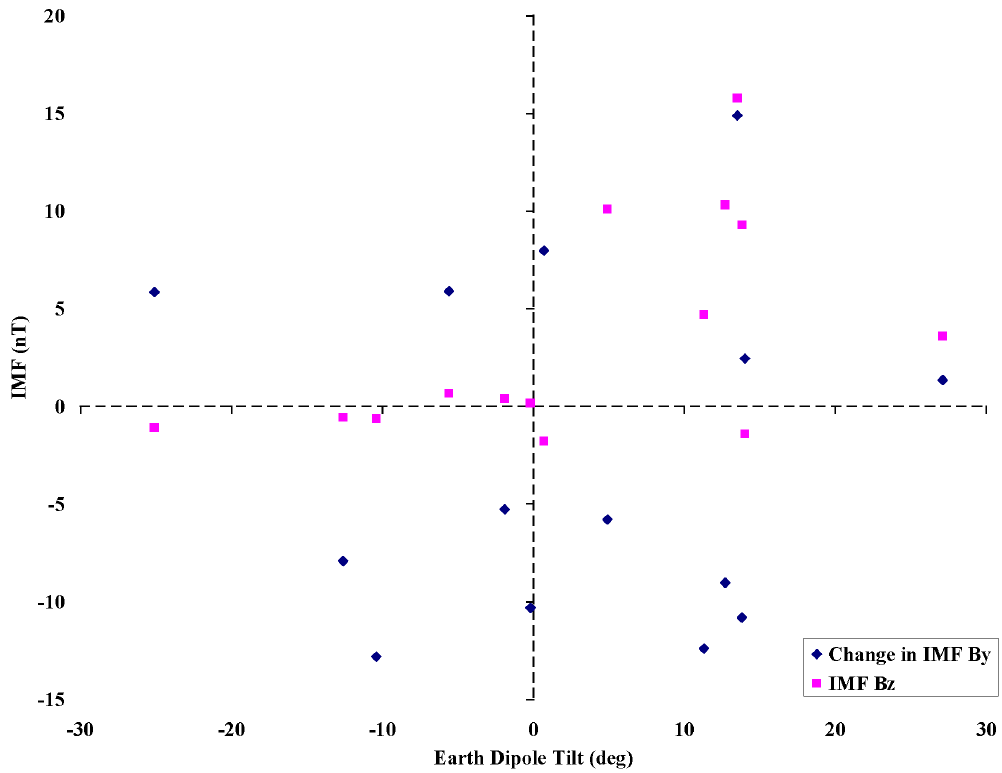
Fig. 7. IMF B z and direction and magnitude of a change in IMF B y versus Earth dipole tilt for the multiple thin arc